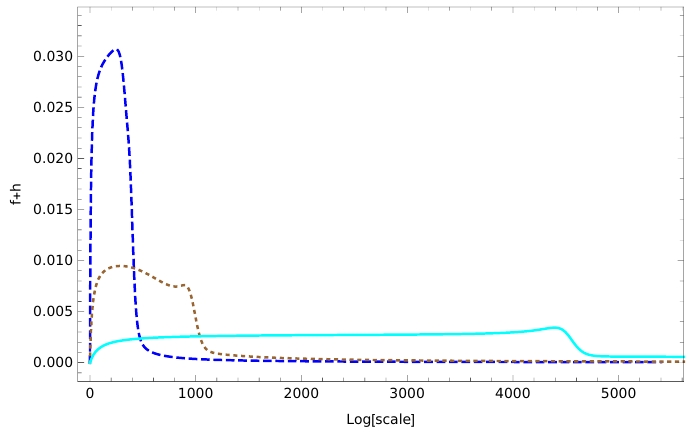
Figure 1 . The dependence of the coupling f + h on the scale for N s = 2 ; N c = 25. We have chosen the scale of symetry breaking to be equal to 1. The various curves from top to bottom correspond to N f = 120 ; 130 ; 135. We can clearly see that the length of the \walking plateau" increases once we go to the smaller values of the